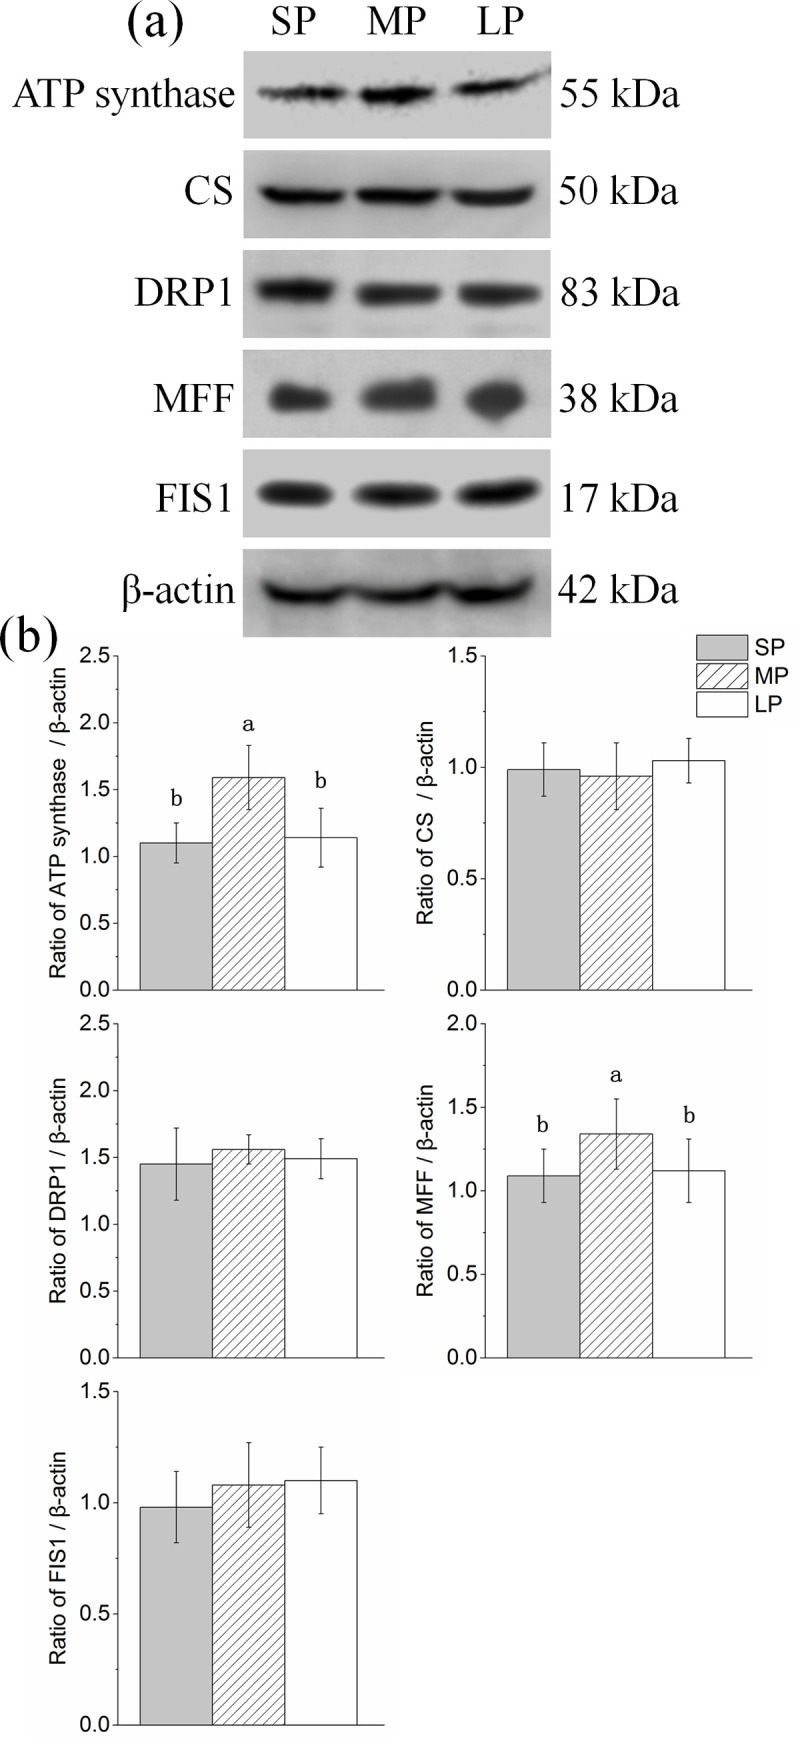
Changes in protein levels of mitochondrial related factors in HG of hamsters in three different photoperiodic groups.(a) Representative immunoblots of ATP synthase, CS, DRP1, MFF, FIS1, and β-actin in three different photoperiodic groups. (b) Ratio of ATP synthase, CS, DRP1, MFF, FIS1 to β-actin in HG of hamsters in three different photoperiodic groups. Values are means ± SD. n = 10. SP, short photoperiod; MP, moderate photoperiod; LP, long photoperiod. Different letters identify statistically significant difference (P < 0.05).